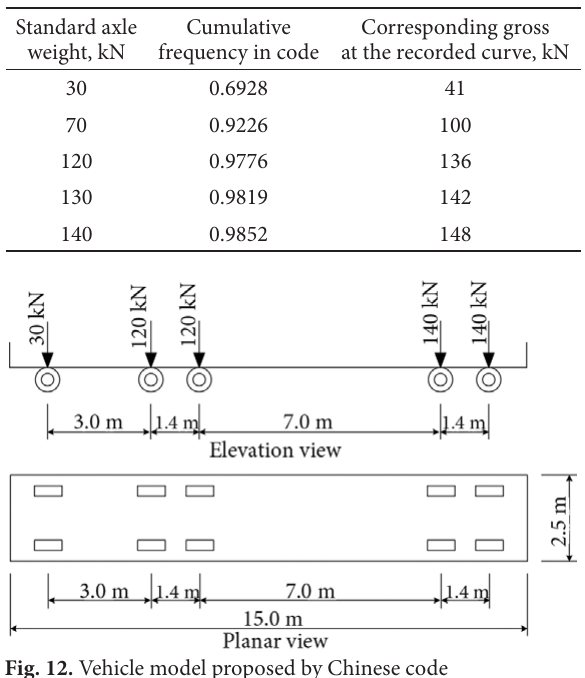
Table 2. Comparison of axle weight at different cumulative frequency